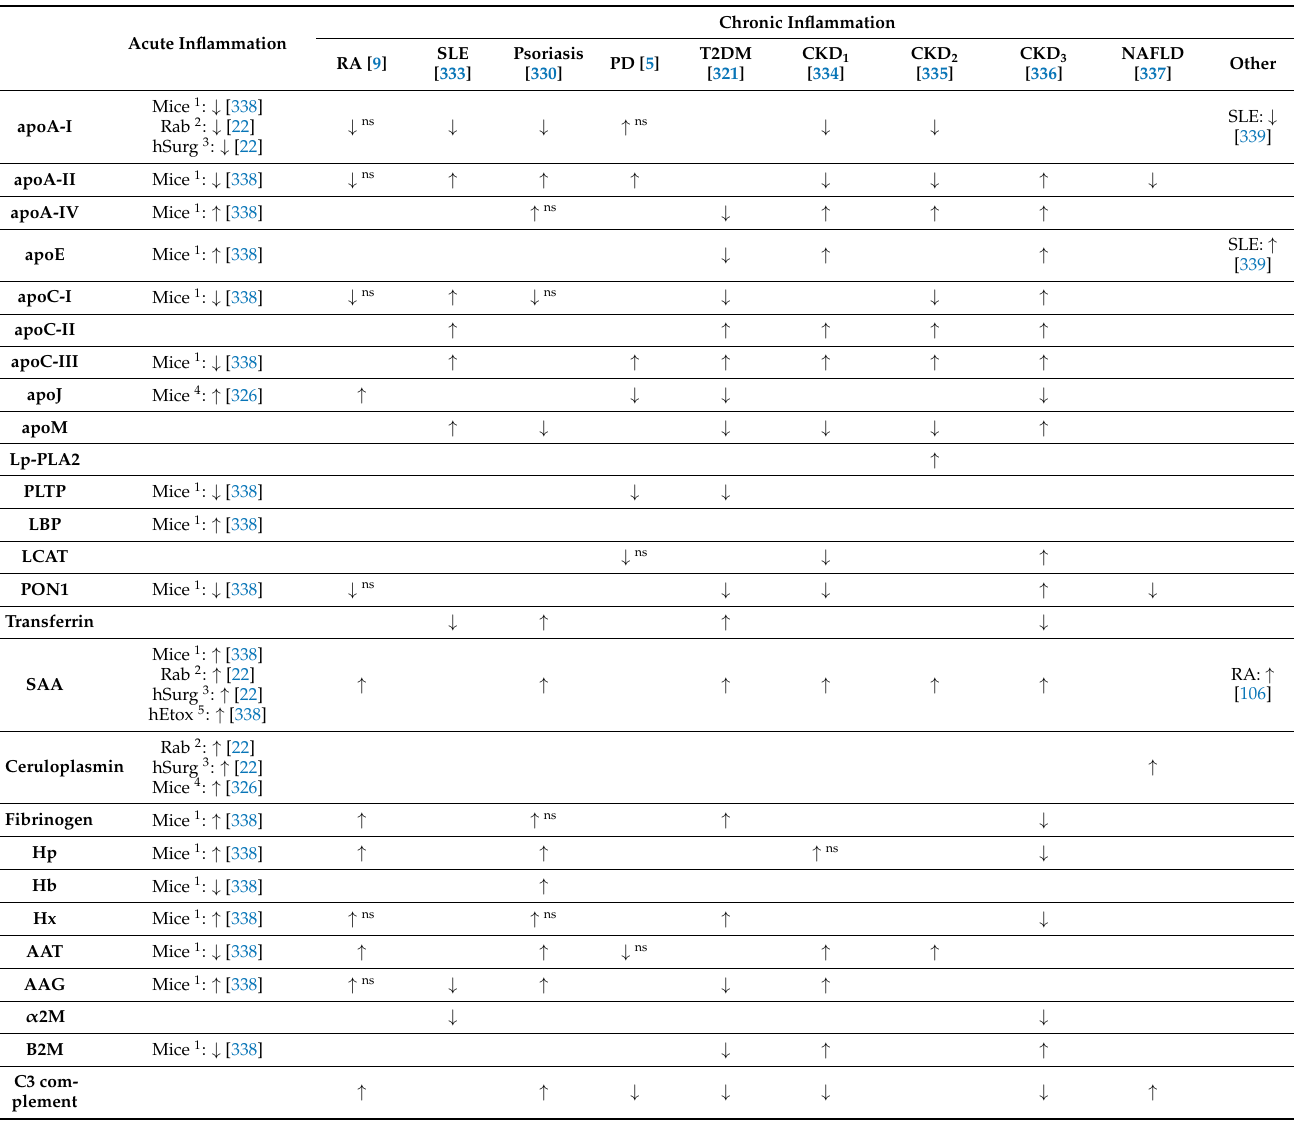
Table 1. Studies of HDL proteome in acute and chronic inflammatory conditions.